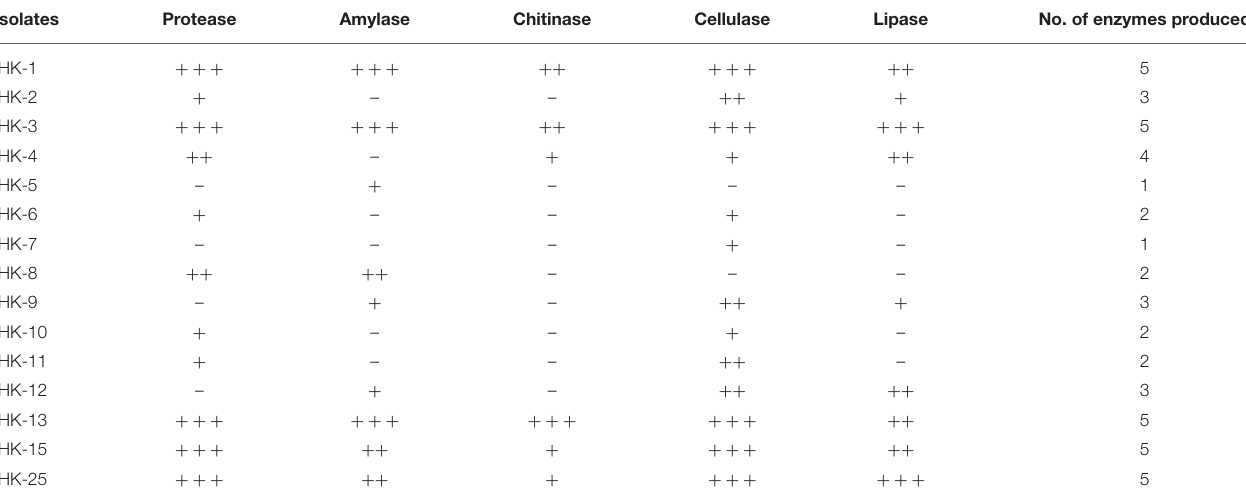
TABLE 3 | Hydrolytic enzymes produced by bacteria isolated from the rhizosphere of rice. Isolates Protease Amylase Chitinase Cellulase Lipase No. of enzymes produced